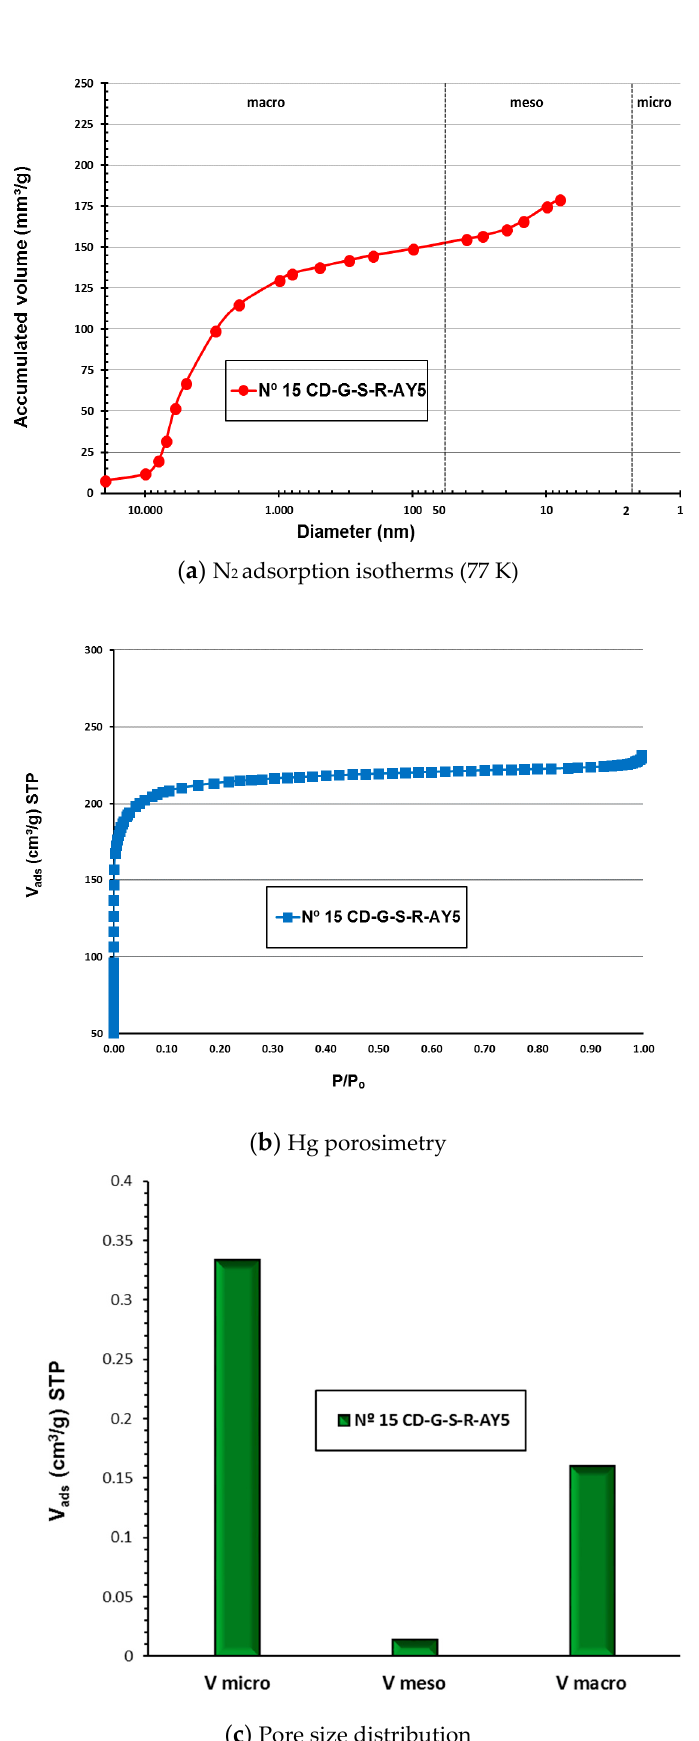
Figure 5. Graphics of textural characterization